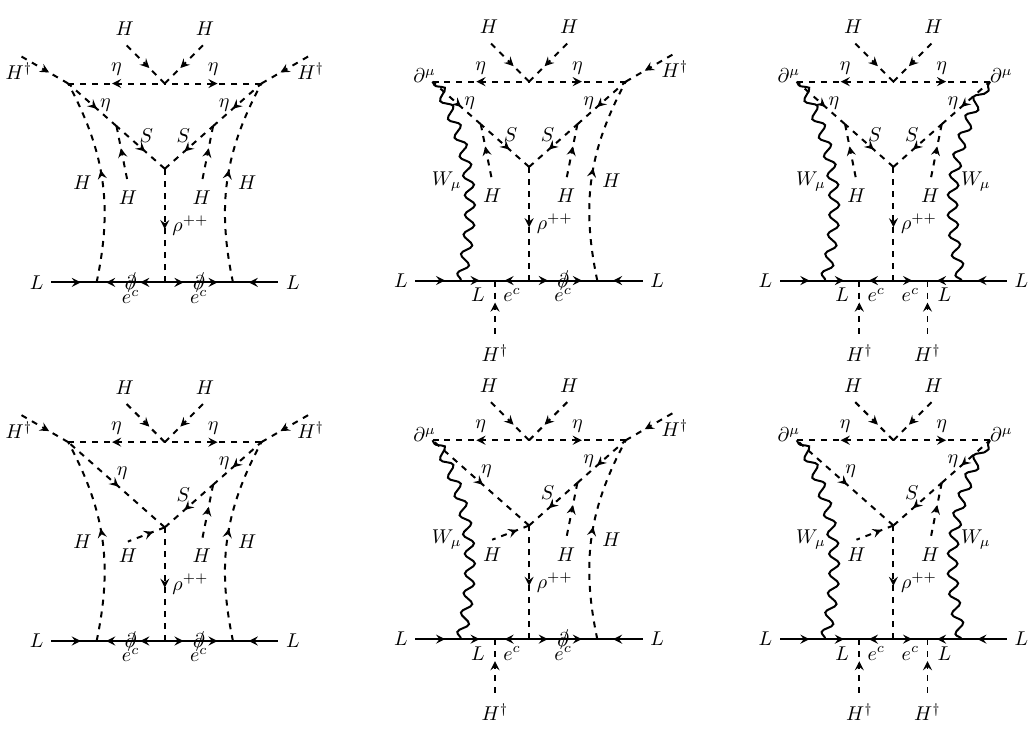
Figure 20 . Dimension 9 mass diagrams in the Feynman-’t Hooft gauge. Denoted as I (9)